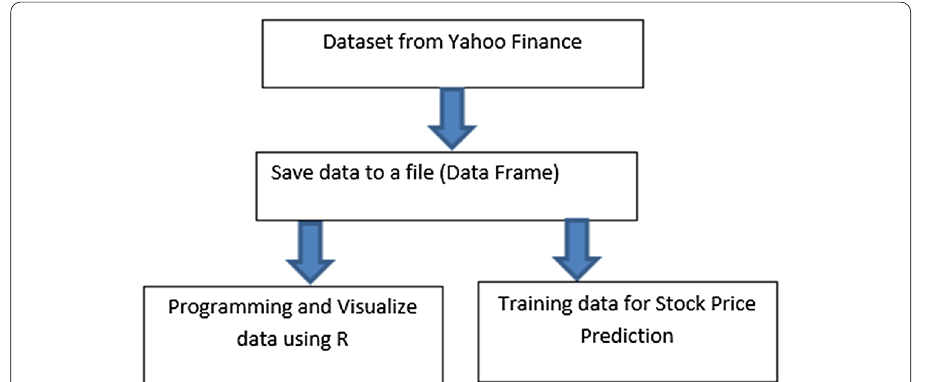
Fig. 4 The model for stock prices prediction using big data from Yahoo Finance